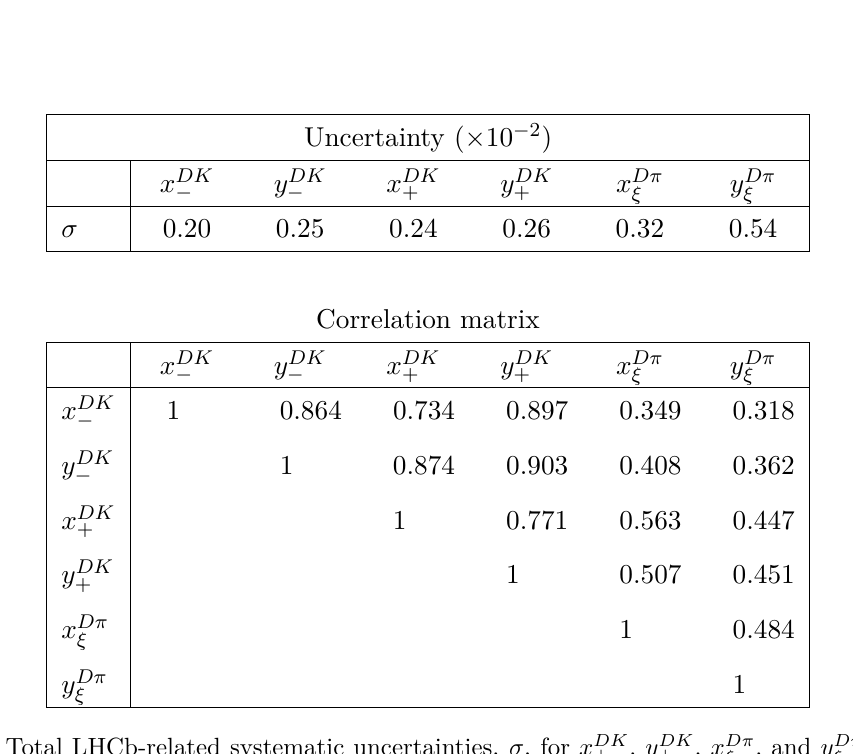
, and the , y DK , x Dπ , and y Dπ ± ± ξ ξ